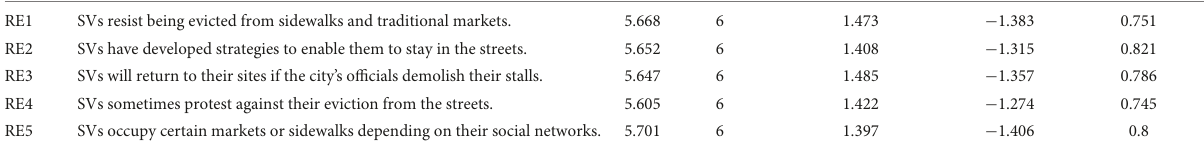
TABLE 8 Measurement properties of resistance. Codes Items